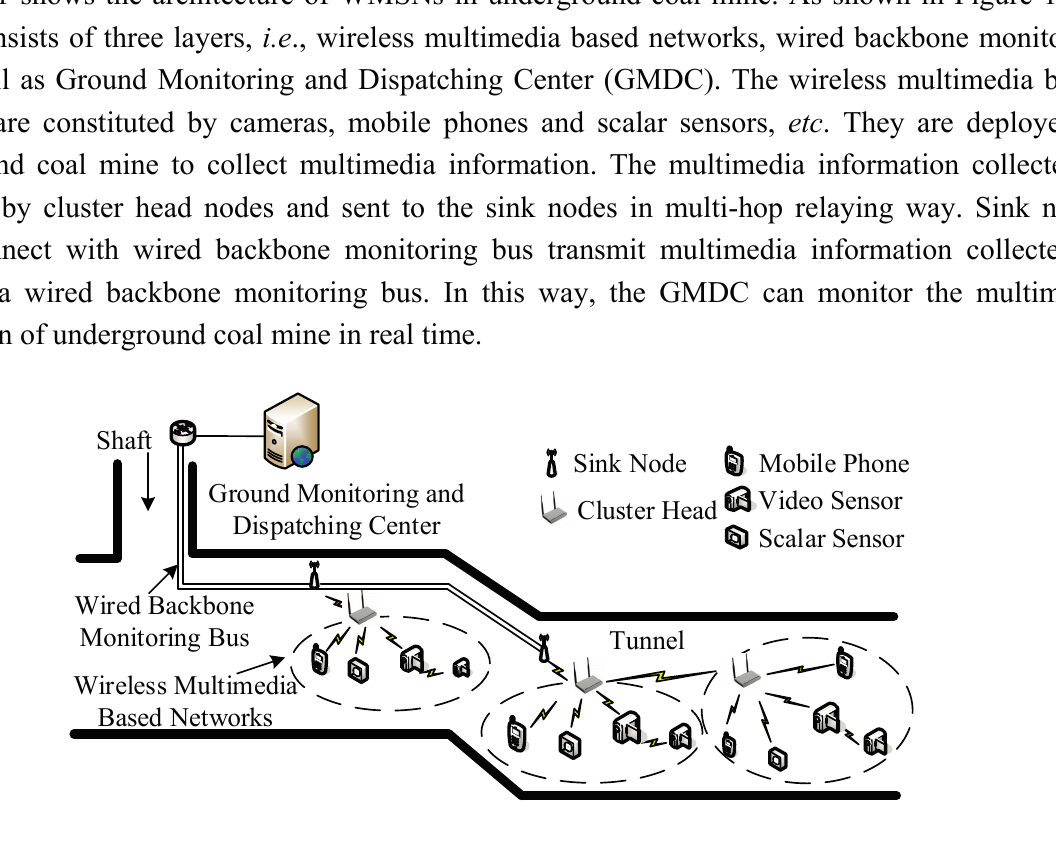
Figure 1. Architecture of wireless multimedia sensor networks (WMSNs) in underground coal